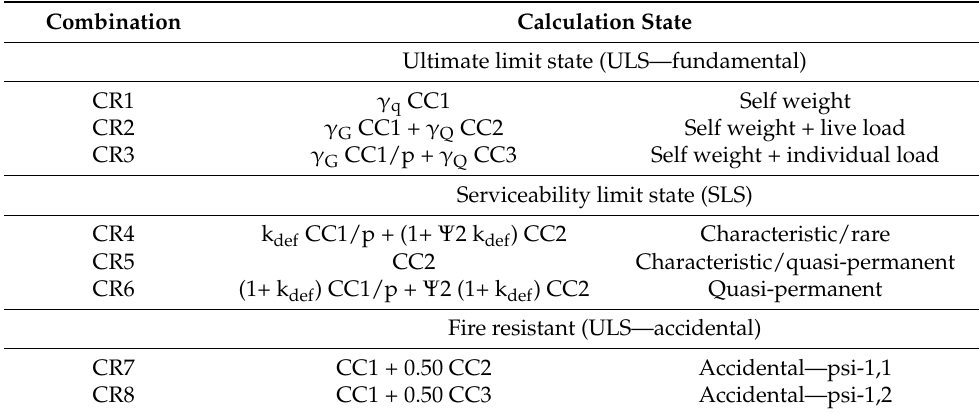
Table 1. Combinations of loads included in the numerical